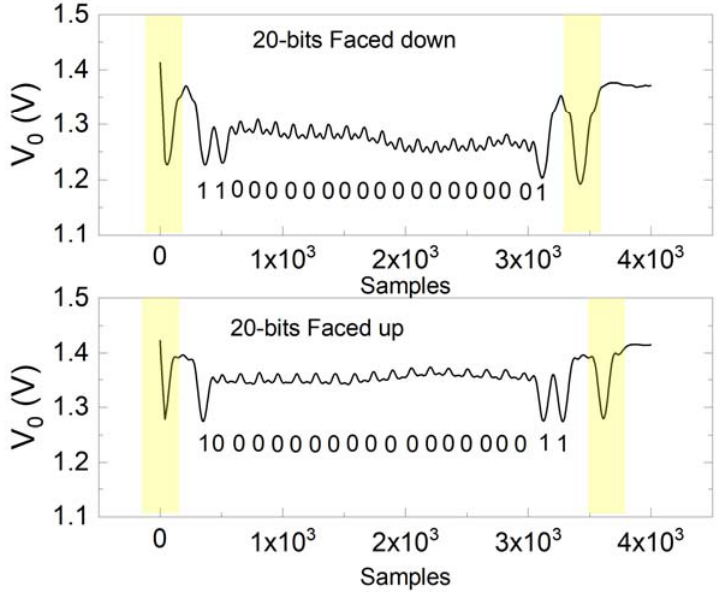
Figure 6. Measured envelope functions of the fabricated tag printed with two ink layers.